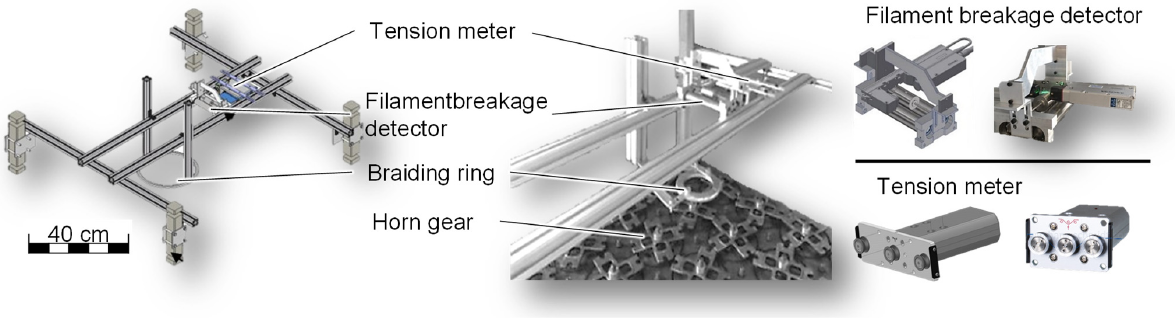
Figure 2. Yarn tension meter and filament breakage rate meter integrated into the 3D braiding process.